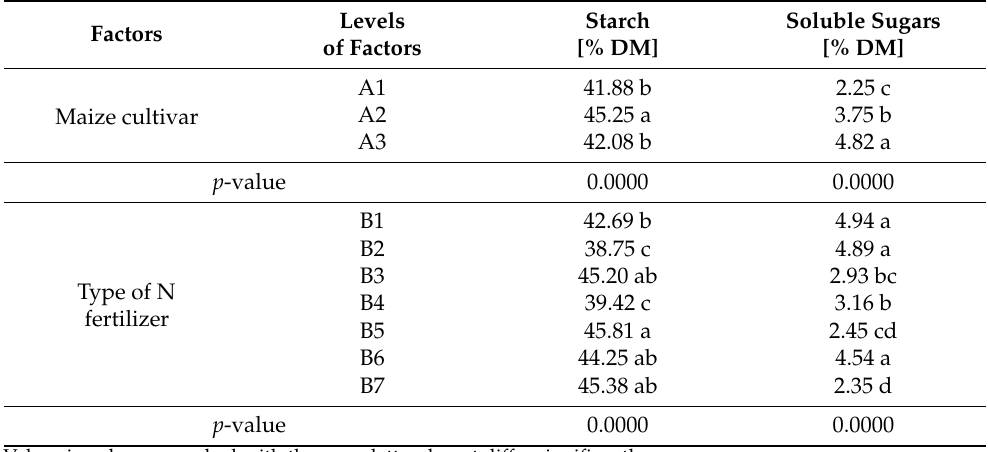
Table 6. Average values of non-structural carbohydrates for cultivars (A) and fertilizer (B). Levels Factors of Factors